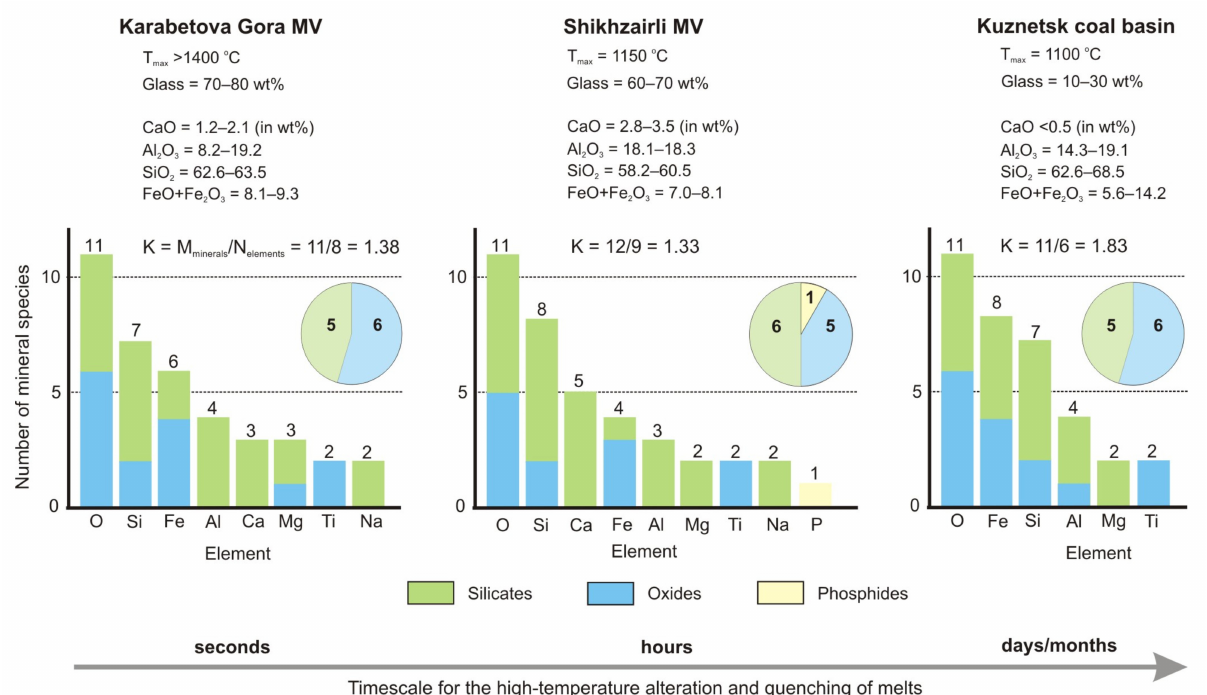
Figure 9. Mineralogical diversity of metapelitic CM rocks produced by Karabetova Gora MV fire eruption and productivity of elements. Compared are compositionally similar metapelitic CM rocks genetically related to Shikhzairli MV gas fire [17] and Kuznetsk basin coal fire